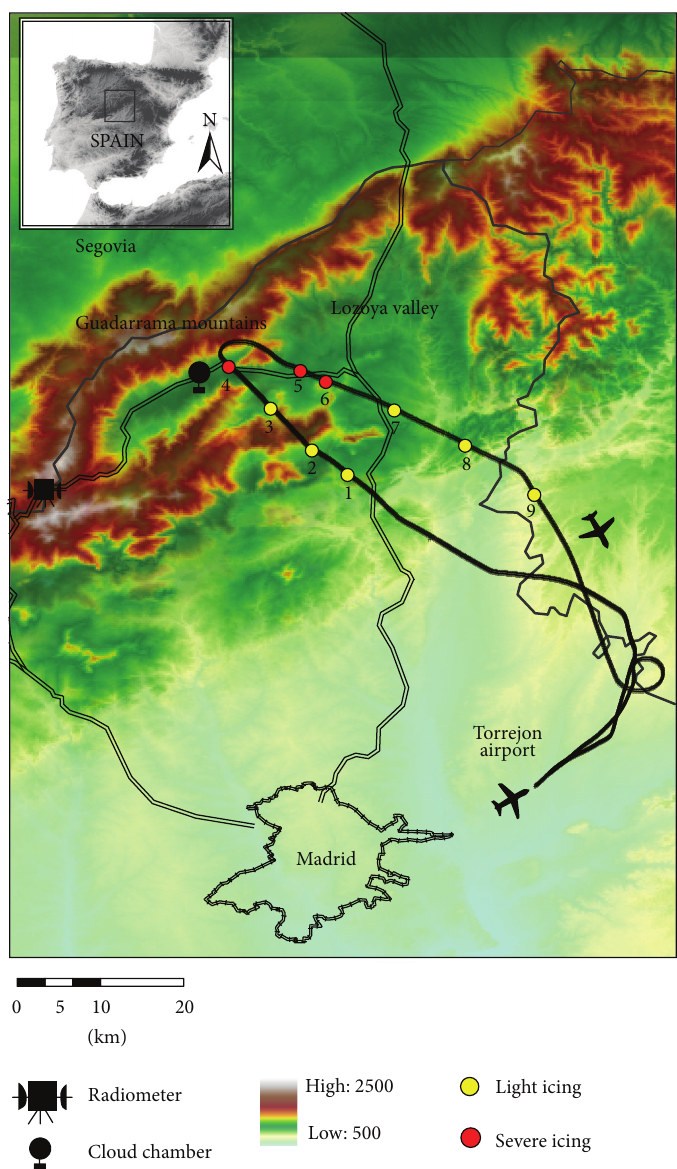
Figure 1: Map of Guadarrama Mountains, Madrid. Aircraft trajectory plus radiometer and cloud chamber locations have been